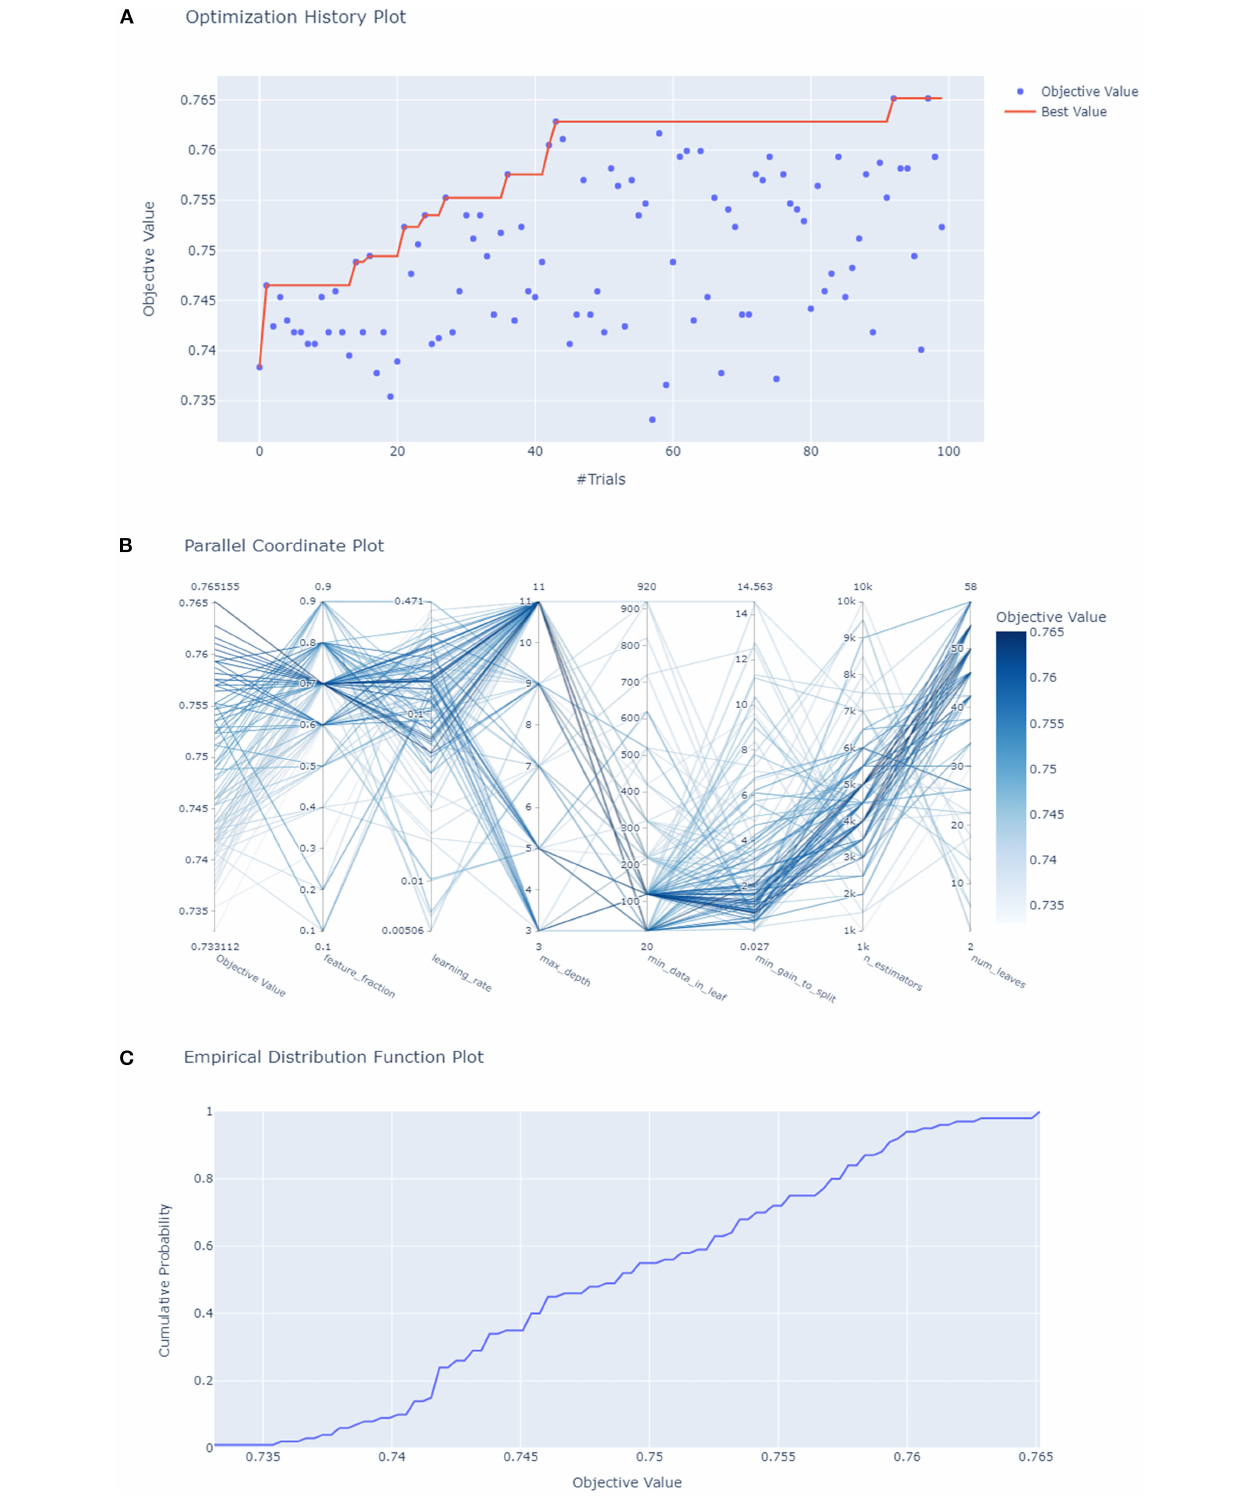
FIGURE 4 | Hyperparameters optimization. (A) Each blue point represents the result of a trial, and the dark orange line represents the best AUROC value; (B) Each line represents a trial, the shade of color represents the performance of optimization; (C) the empirical distribution function of HPO.